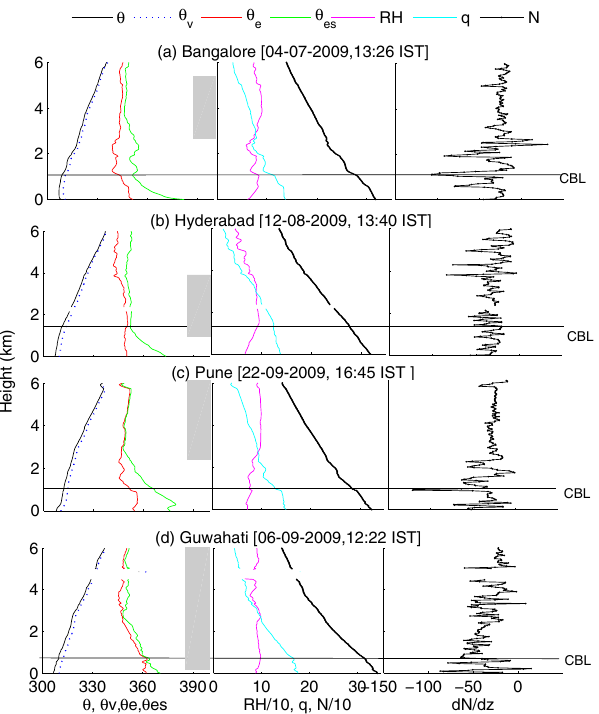
Figure 6. Same as Fig. 4 but observed over (a) Bangalore on 4 July 2009, (b) Hyderabad on 12 August 2009, (c) Pune on 22 September 2009, and (d) Guwahati on 6 June 2009, indicating the CBL and the cloud layer. The grey rectangular box indicates the cloud layer representing the location with RH >